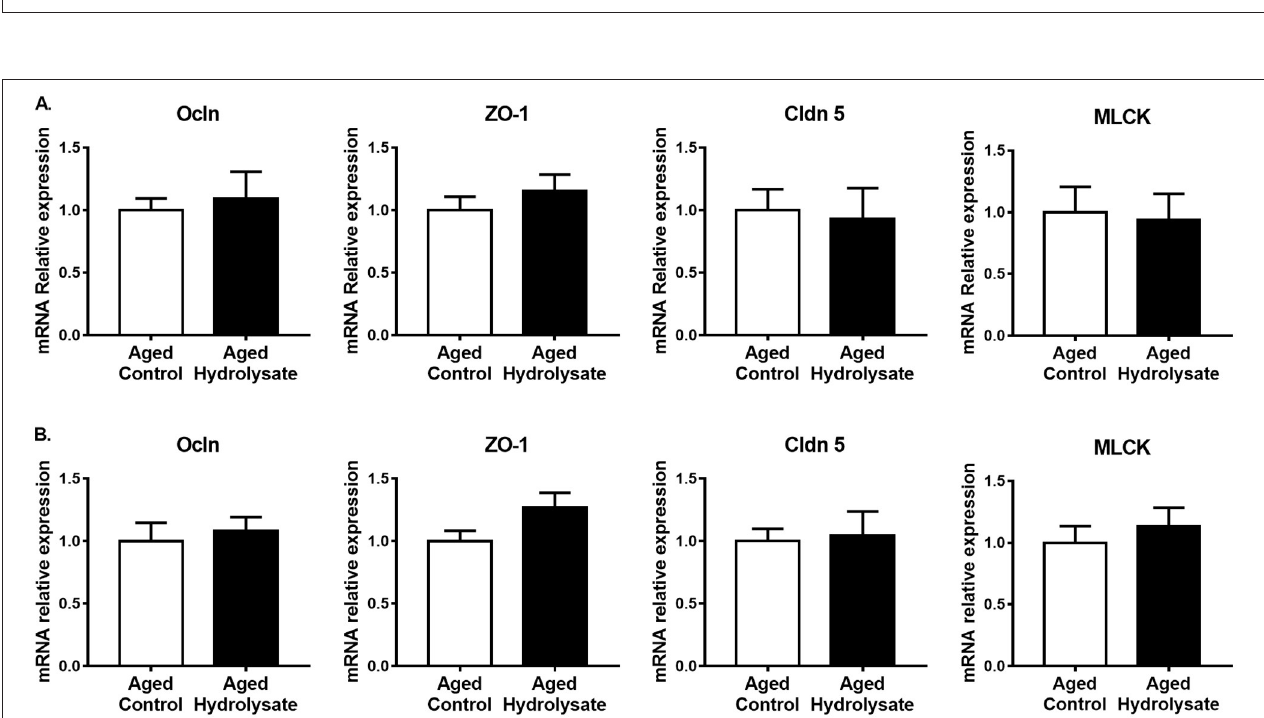
FIGURE 9 | Effects of the fish hydrolysate supplementation on gene expression of intestinal permeability markers. Intestinal permeability markers Ocln, ZO-1, Cldn 5 and MLCK mRNA expressions in (A) the ileum and (B) the colon of aged mice fed with the control diet or the hydrolysate-enriched diet for 10 weeks. n = 8 per group. Data are presented as mean ±